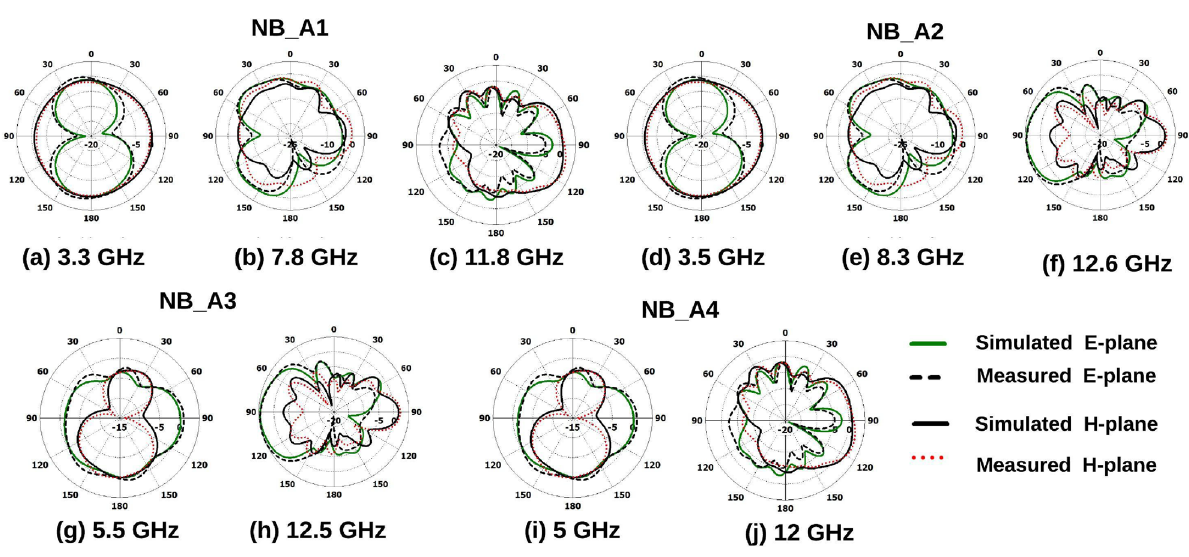
Figure 18. Radiation pattern of NB